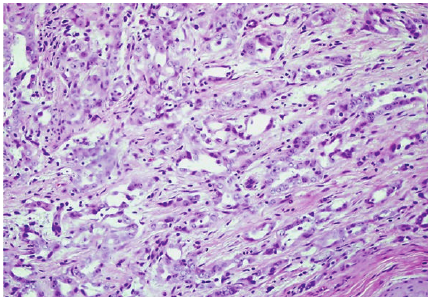
Figure 1: Abdominal mass biopsy showing mesothelioma (H&E, low power).